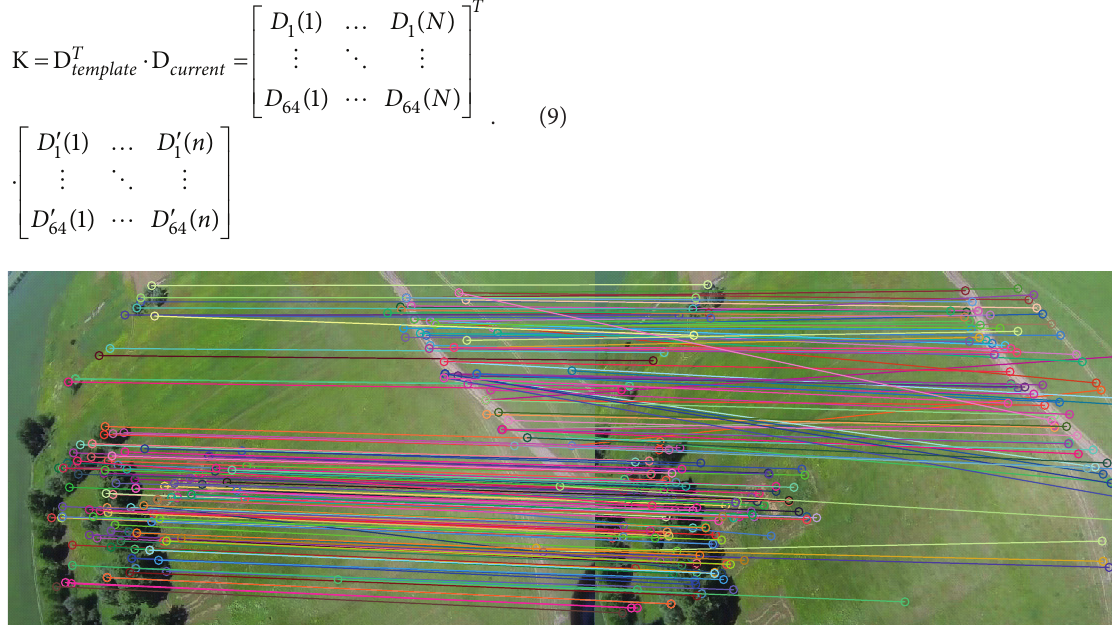
Fig. 3. The matching of two video frames from aboard a UAS with a difference of 10 frames (0.4 sec, 25 fps) with the correlation threshold K = 0.95. The number of false matching is 73 from a total of 189 matching features (on very similar areas of road). The average time for computing the matches is 0.0067